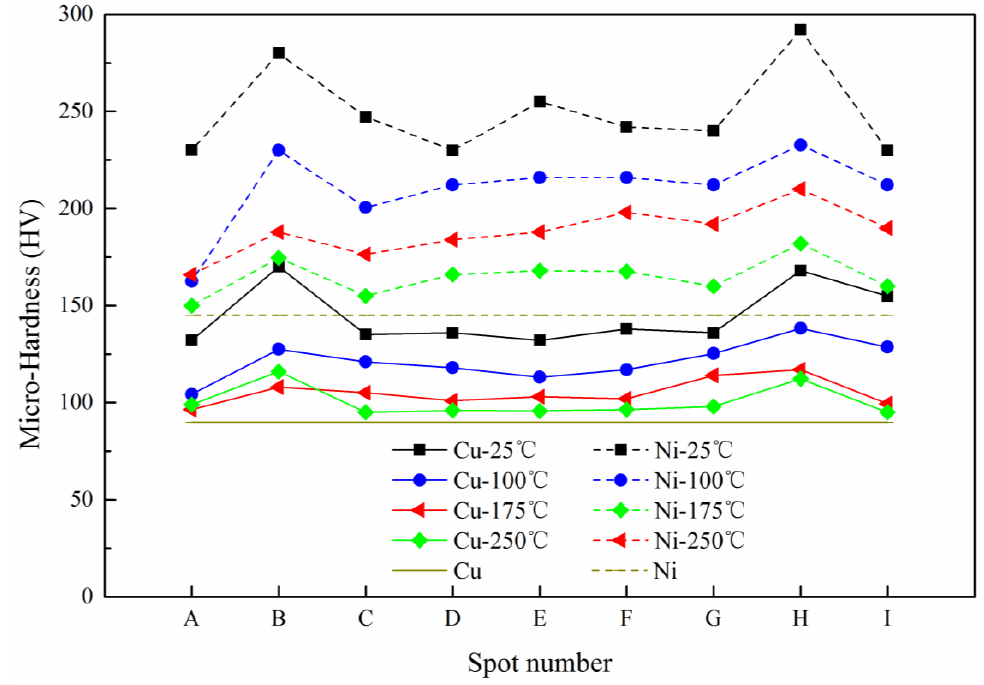
Figure 22. The micro-hardness distribution of Cu and Ni at 1800 mJ.